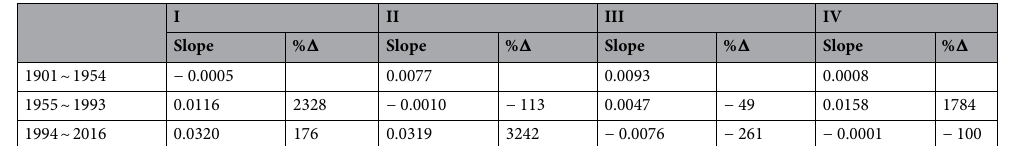
c i a i 0 t a i 1 ( t T 1 ) a i 2 ( t T 2 ) + + + with = + + − − a i 1 for 1955–1993, and +